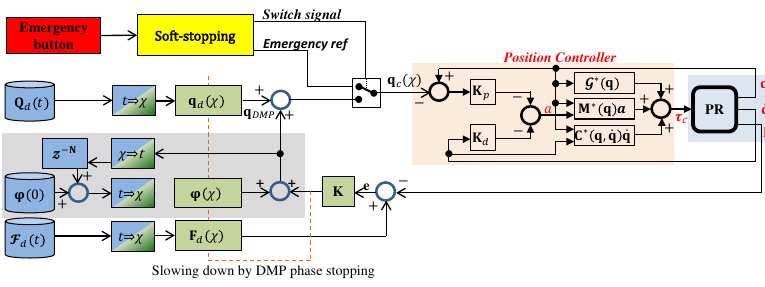
Figure 6. Control